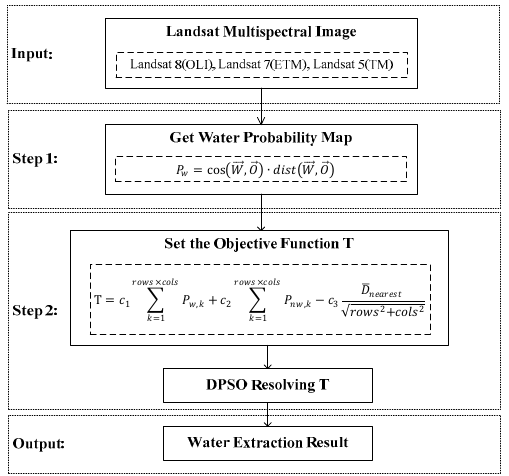
Figure 4. Steps of extracting the water surface area using the SMDPSO method.